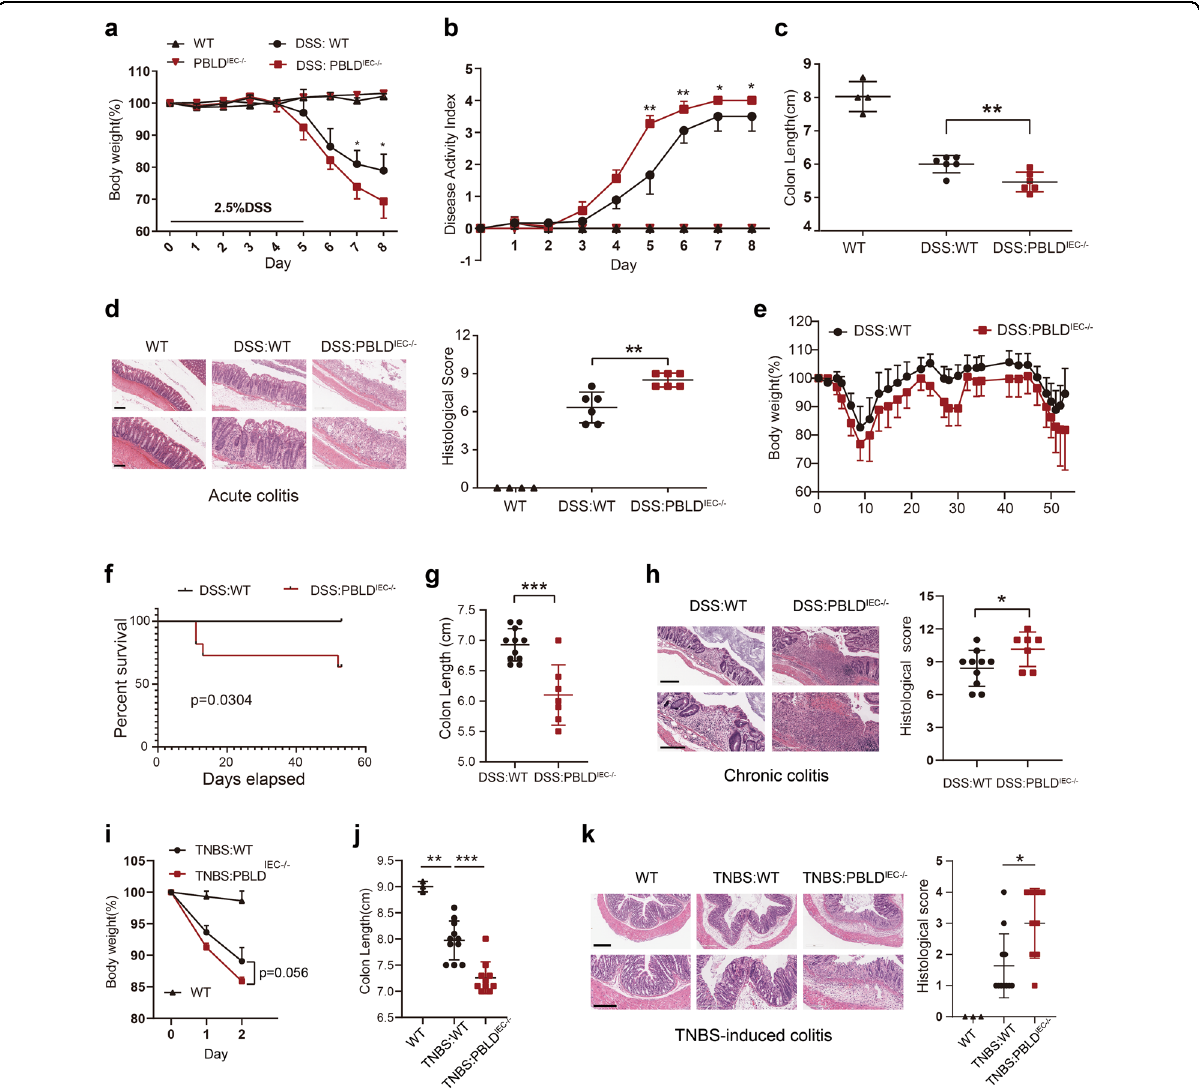
Fig. 2 Deletion of PBLD in IECs aggravates DSS- and TNBS-induced colitis in mice. a Body weight curve and b disease activity index of wild- type (WT) and PBLD IEC − / − mice treated with DSS for 5 days, followed by 3 days regular drinking water (WT, n = 4; PBLD IEC − / − , n = 4; DSS:WT, n = 6; DSS:PBLD IEC − / − , n = 6). c Colon length of mice sacri fi ced at day 8. d Representative HE-stained colon sections in mice (left) and their corresponding histological score (right) ( n = 4 – 6). Scale bars: 200 μ m in upper,100 μ m in lower. e Body weight curve and f survival curve in the DSS-induced chronic colitis model in WT and PBLD IEC − / − mice ( n = 11 in each group). g Colon length of mice sacri fi ced at the end of chronic colitis model ( n = 7 – 11). h Representative HE-stained colon sections in mice with chronic colitis (left) and their corresponding histological scores (right; n = 7 – 10). Scale bars: 300 μ m in upper, 200 μ m in lower. Data are mean ± standard deviation (SD). *** p < 0.001. i Body weight changes in WT mice and PBLD IEC − / − mice after TNBS administration. j Colon length in mice after 2 days of TNBS treatment ( n = 3 – 11). k HE-stained colon sections in mice after 2 days of TNBS treatment (left) and their corresponding histological scores (right). Scale bars: 300 μ m in upper, 200 μ m in